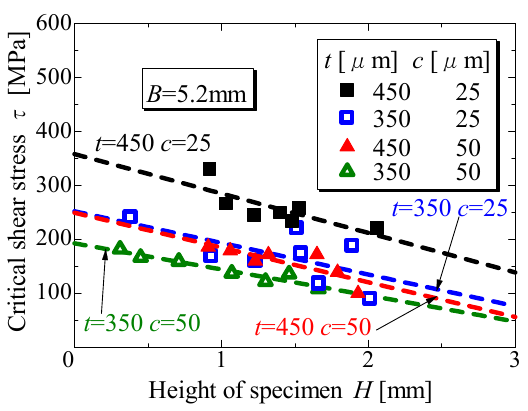
Figure 4. Influence of specimen height on failure stress: Apparent failure stress decreases with increasing specimen height.